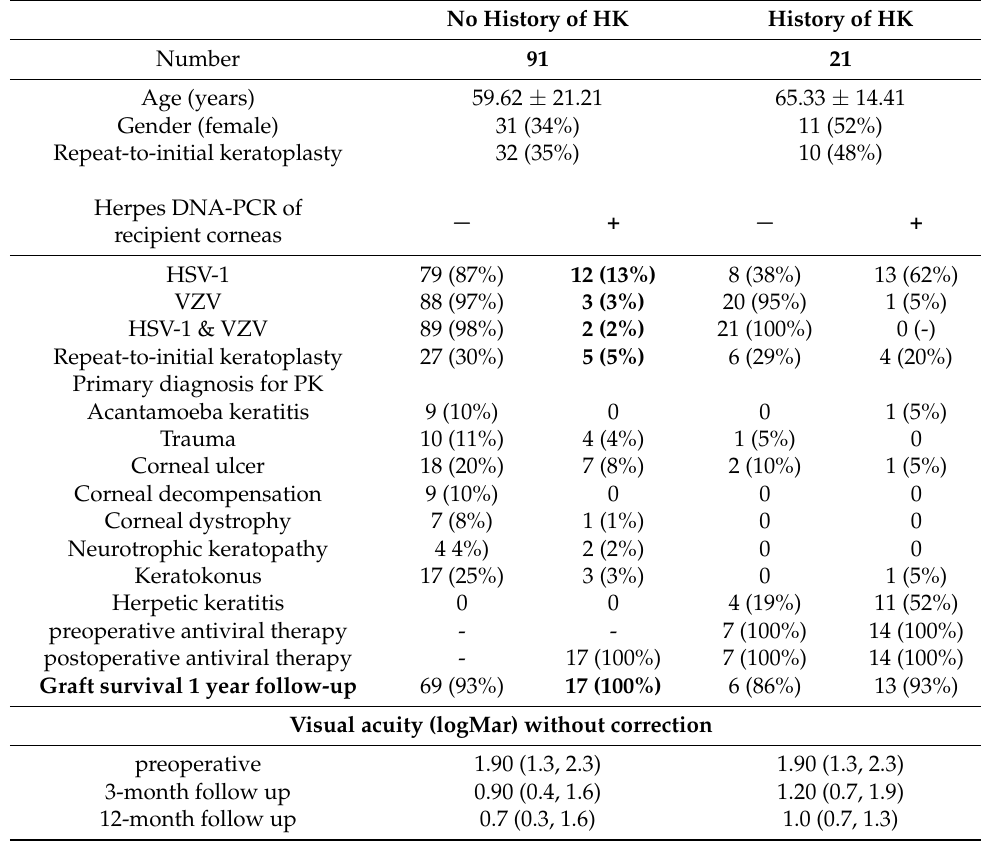
Table 1. Results of HSV-1 and VZV DNA in corneal transplant recipients for